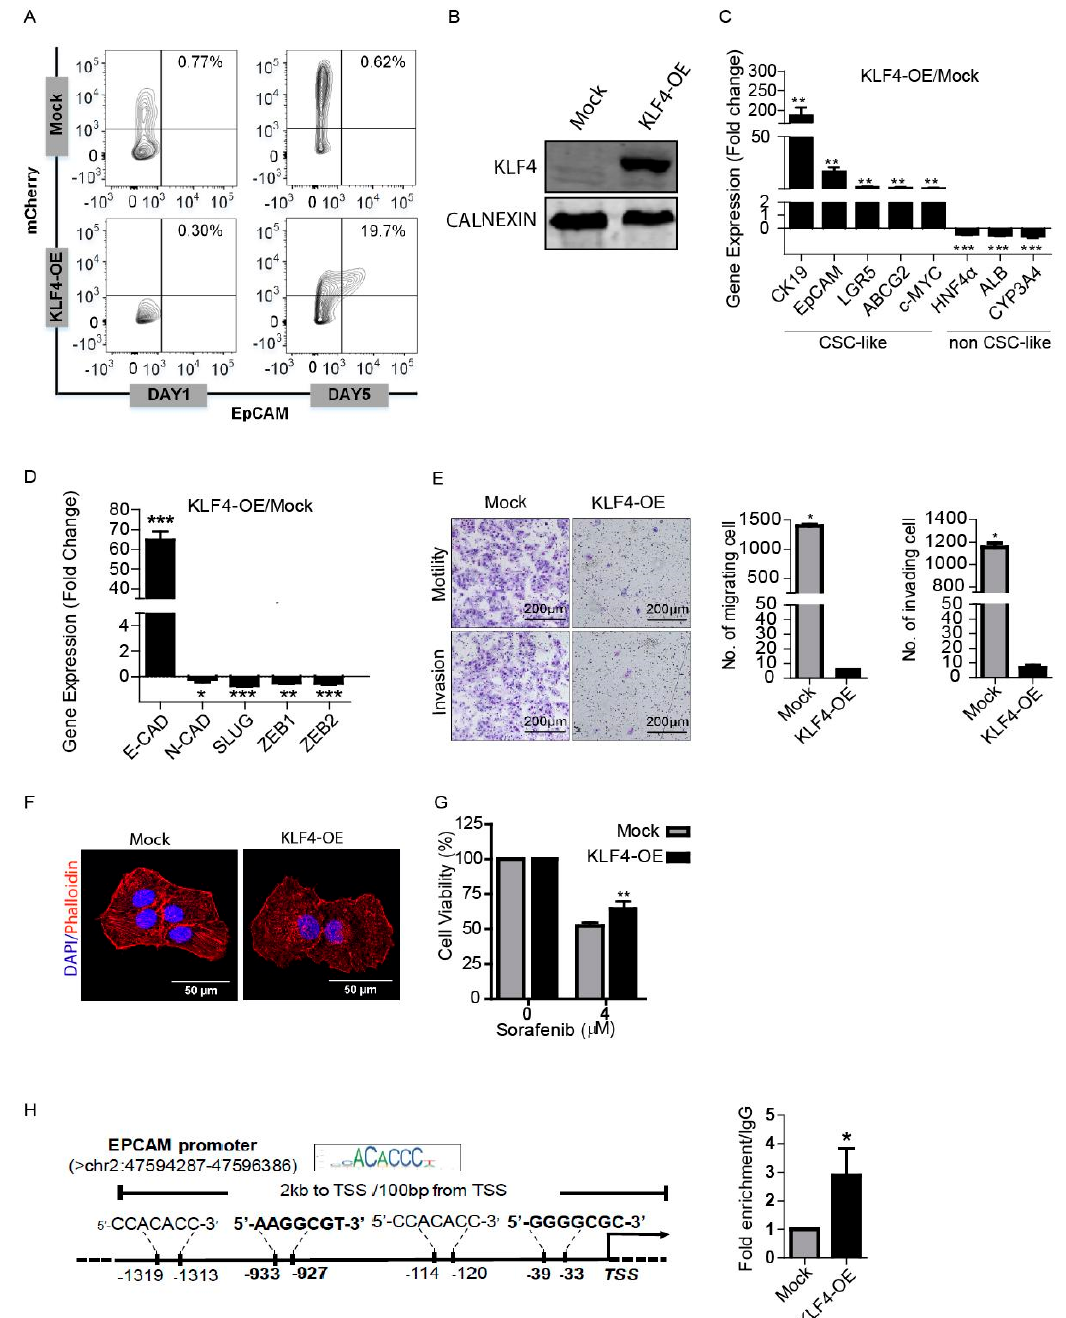
Figure 2. KLF4 modulates stemness and the phenotypic shift of non-stem cells. ( A ) Non-stem cells were transduced with KLF4-mCherry and mock mCherry plasmids. The effect of KLF4 on the EpCAM cell population was analyzed by flow cytometry. ( B ) Western blotting analysis of KLF4 expression in the mock vs. the overexpressing cells. ( C ) Transcriptional expression of cancer stem cell (CSC)- and non-CSC-related genes were measured by real-time PCR. Column graphs show the fold change normalized to RPL41 and calculated by using the 2 −ΔΔ Ct method. ( D ) Epithelial and mesenchymal marker gene expressions were analyzed using real-time PCR. Column graphs show the fold change normalized to RPL41 and calculated by using the 2 −ΔΔ Ct method. ( E ) Non-stem cells were transduced with KLF4-mCherry and mock-mCherry plasmids and then the migration and invasion capacity of the cells were assessed by the transwell chambers. Representative images of migrated and invaded cells are given. The number of stained cells is presented as column graphs on the right. ( F ) KLF4-overexpressing and mock cells were stained with tetramethylrhodamine (TRITC)-labeled